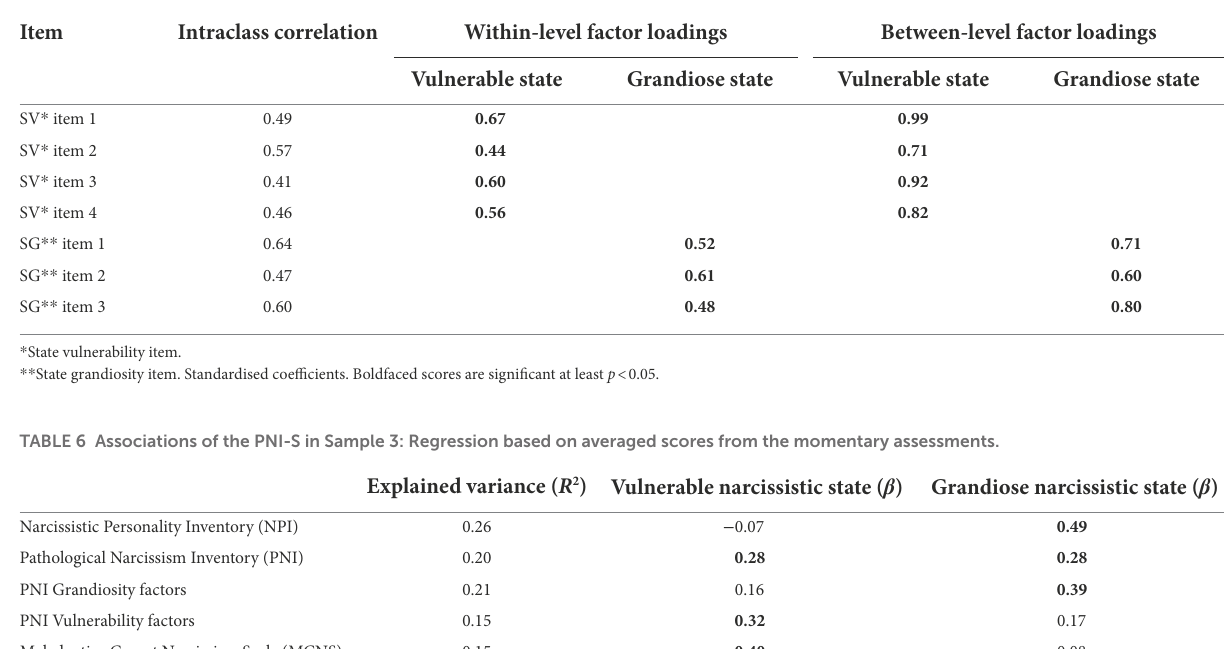
TABLE 5 Standardised factor loadings and intraclass correlations of the multilevel CFA.